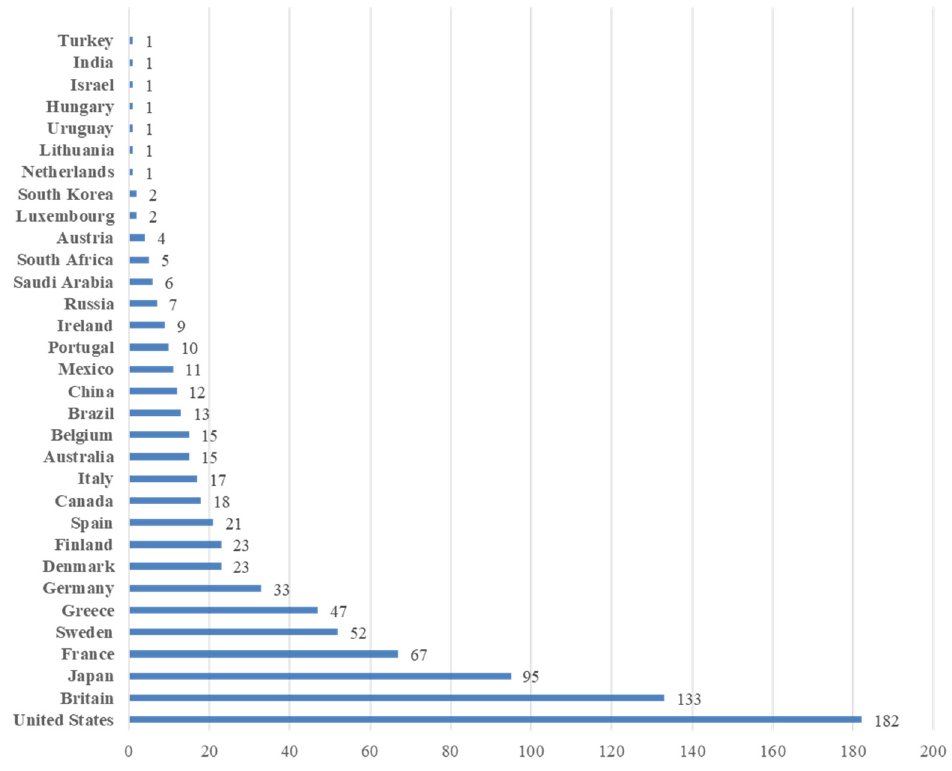
Figure 2. The distribution of countries of samples.